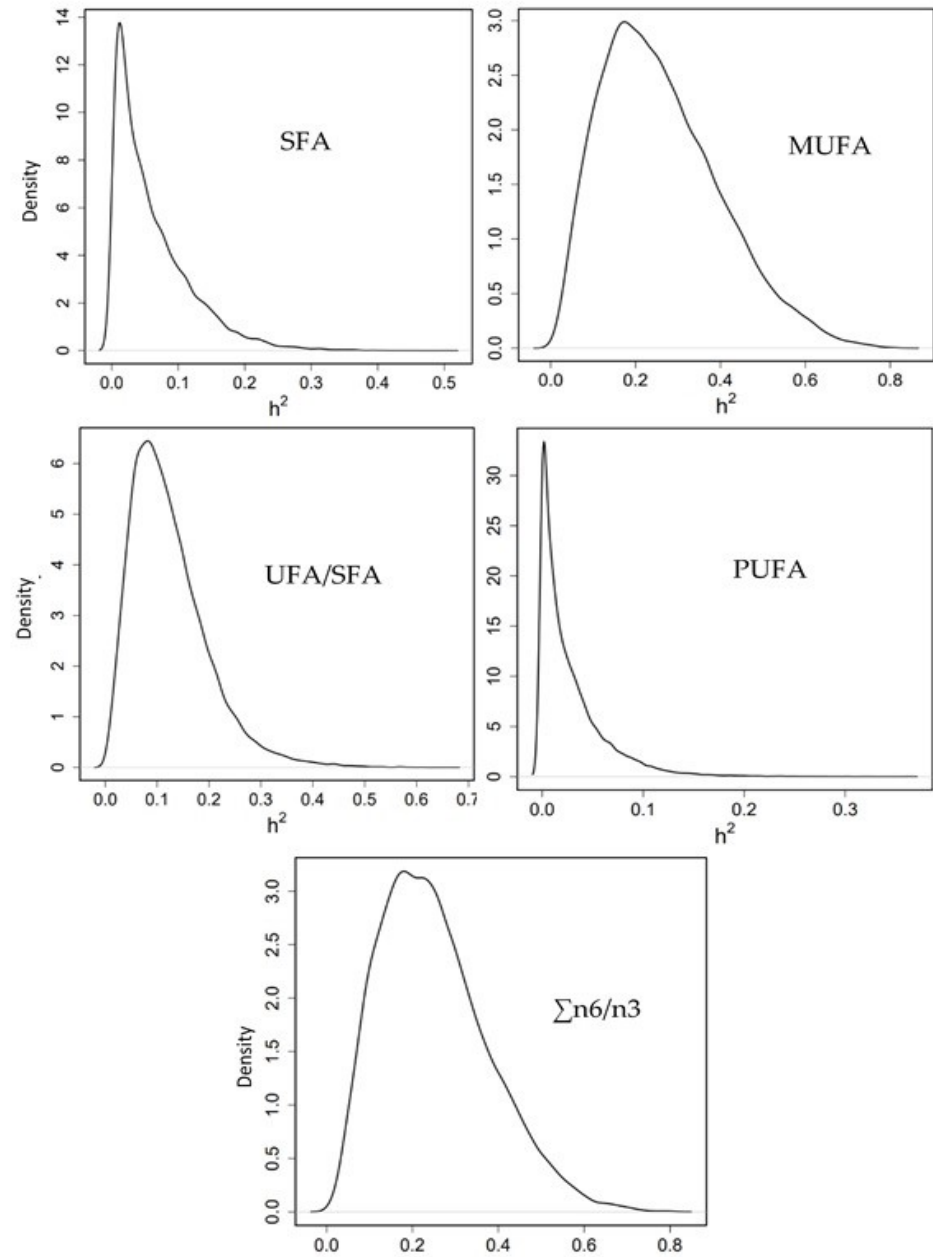
Figure 3. Posterior marginal distribution of heritabilities of fatty acids profile in gilthead seabream. h2 = heritability. n = 399.